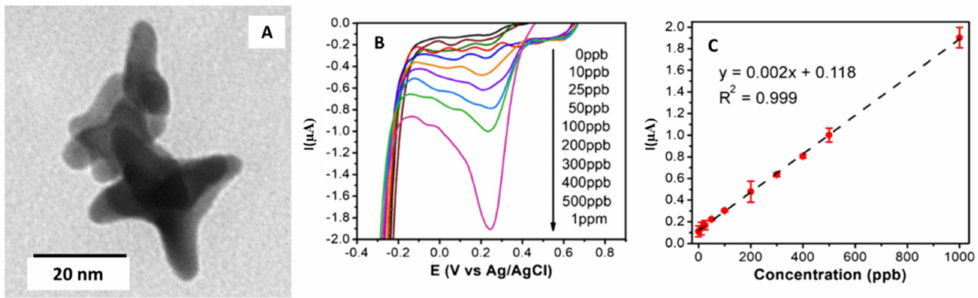
Figure 7. ( A ) TEM micrograph of gold nanostars. ( B ) Linear sweep voltammograms obtained with the SPE modified with the gold nanostar in 0.1 M H 2 SO 4 with Cr(VI) additions between 0 and 1000 µ g · L − 1 . ( C ) Calibration curve obtained for the Cr(VI) additions. Reproduced with permission of Dutta et al., Microchimica Acta; published by Springer, 2019